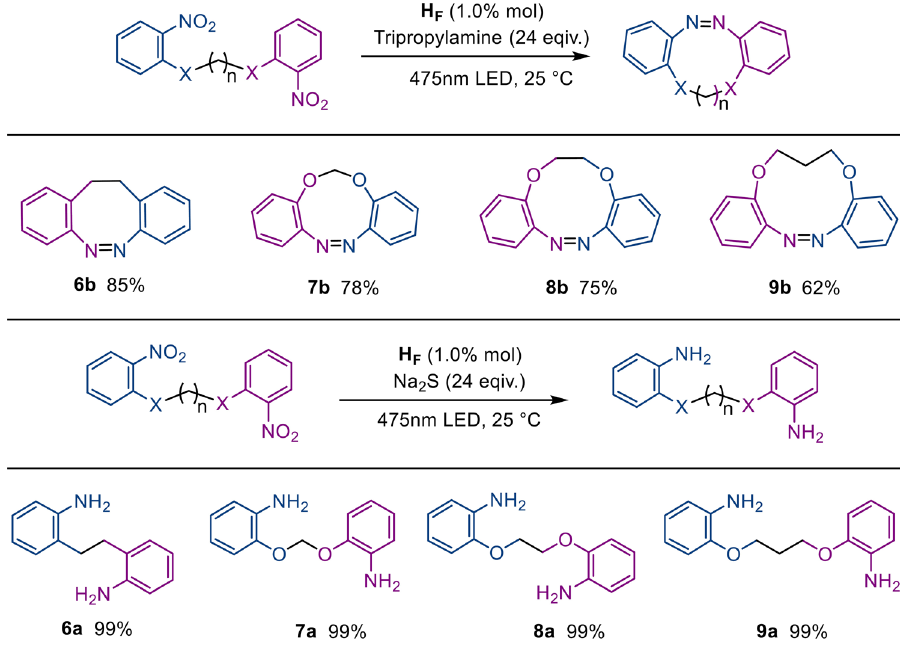
Fig. 7 Photocatalyzed reduction of dinitro substrates using different reductants. Isolated yields are reported. Standard conditions for cyclic azo product conversion were as follows: 1.0 mol% H F (0.50 μ mol), substrate (0.05 mmol) and tripropylamine (1.20 mmol) under light irradiation for 10 h. Standard conditions for diamino product conversion were as follows: 1.0 mol % of H F (0.50 μ mol), substrate (0.05 mmol) and Na 2 S (1.20 mmol) under light irradiation for 2